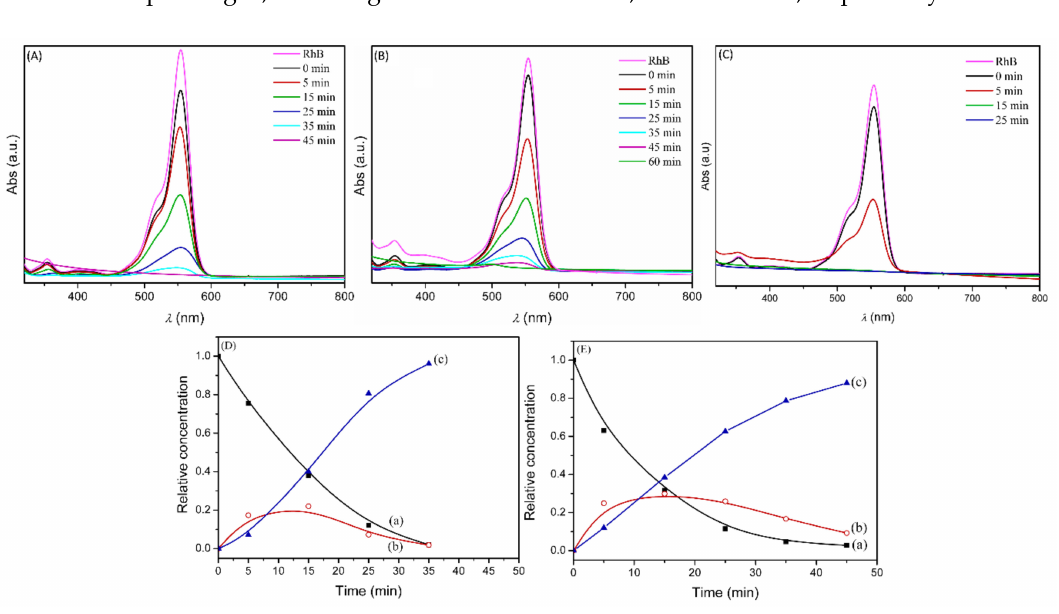
Figure 6. Photodegradation of 10 − 5 M RhB solution by LDH1, LDH2 and LDH3 catalysts (mg Ag / mL RhB = 0.15). Temporal evolution of UV–Vis spectra of LDH1 ( A ), LDH2 ( B ) and LDH3 ( C ); relative concentration of RhB (a), de-ethylated species (b), and cleaved species (c) in the presence of LDH1 ( D ), LDH2 ( E